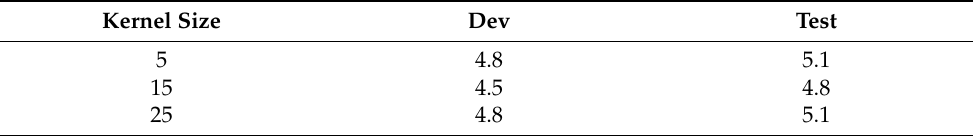
Table 6. Influence of different kernel size on experiment